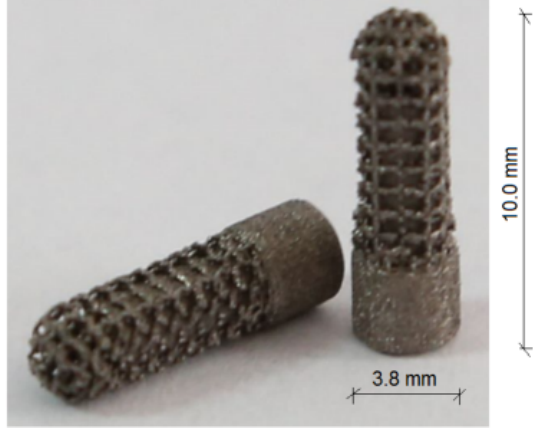
Figure 8. Whole implant body of the implant for further research. Implant has a homogeneous stem and an outer layer comprising of the trabecular struc- ture. The implant has been patented in Czech Repub- lic